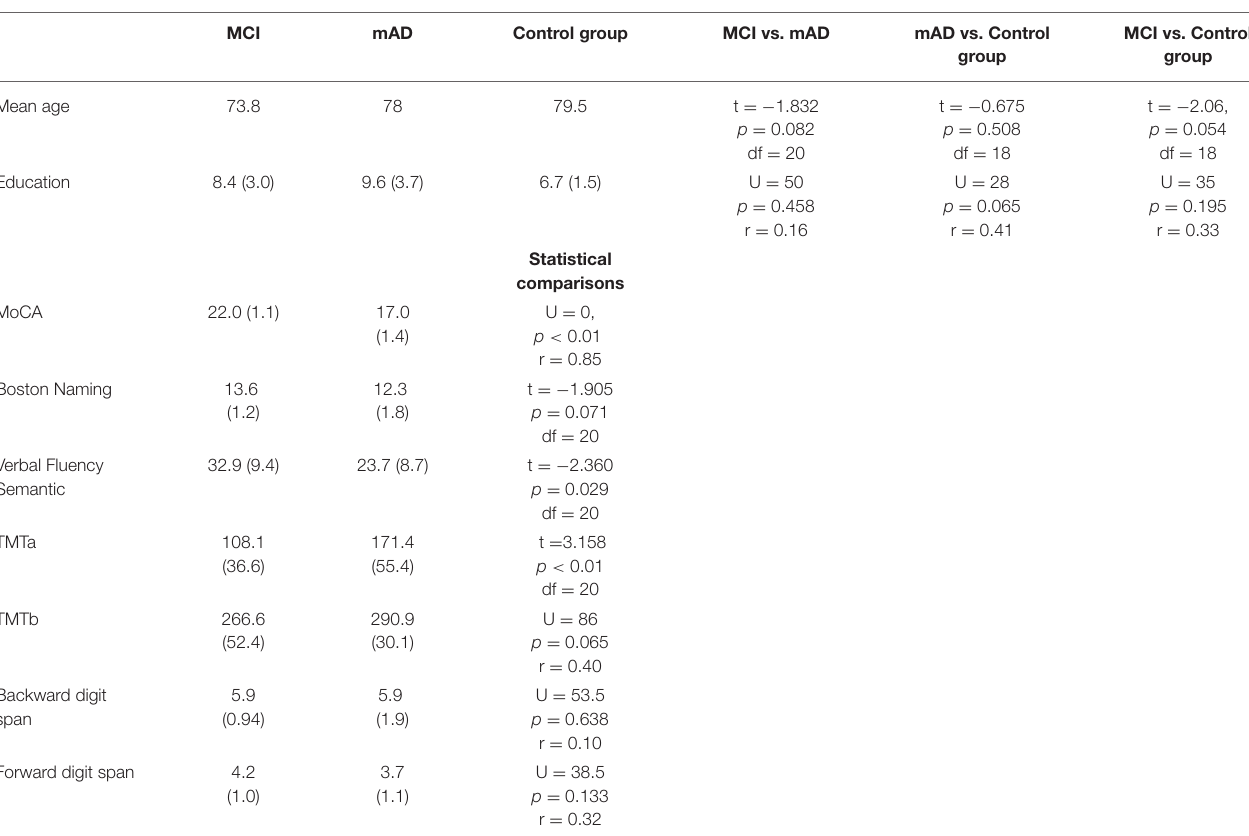
TABLE 3 | Participants’ demographic and neuropsychological mean scores (with standard deviations) and their statistical comparisons by using t -tests (for normally distributed data) and Mann-Whitney tests (for not normally-distributed data). MCI mAD Control group MCI vs. mAD mAD vs. Control